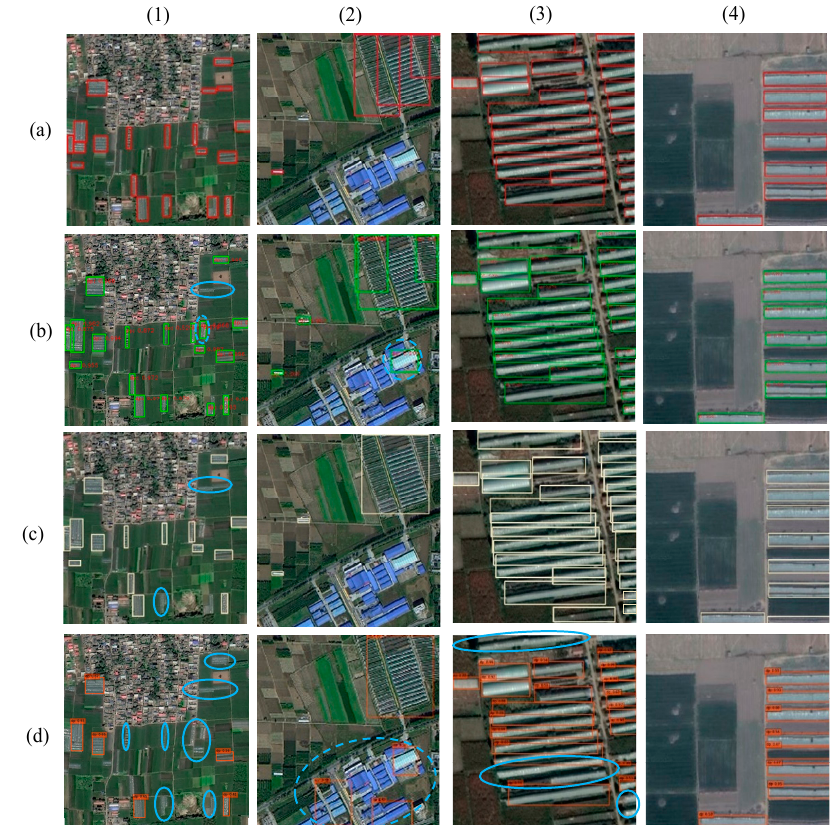
Figure 5. Four subsets ( a ) ground-truth and detection results of different scenarios using ( b ) Faster R-CNN, ( c ) YOLO v3, ( d ) SSD. ( 1 ) Targets surrounded by crop land and residential areas in GF-1 image; ( 2 ) targets surrounded by industrial buildings in GF-1 image; ( 3 ) fragmented and serried targets in GF-2 image; ( 4 ) simple surroundings and regular targets in GF-2 image. Solid and dotted blue circles represent the existence of missing and erroneous detections, respectively.